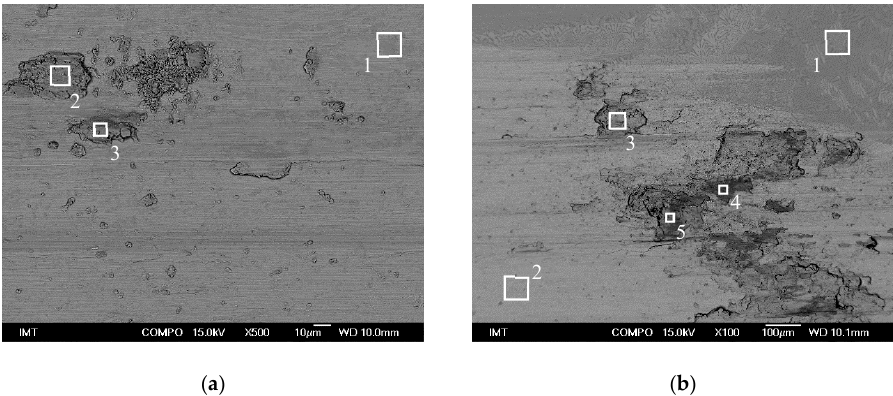
Figure 12. SEM-BSE images with EDS analyses on the wear track of AlCoCrFeNi 2.1 in the as-cast state: ( a ) Inside the wear track; ( b ) At the edge of the wear track. Table 2. Elements concentration in at% from EDS point analyses in Figure 12a.